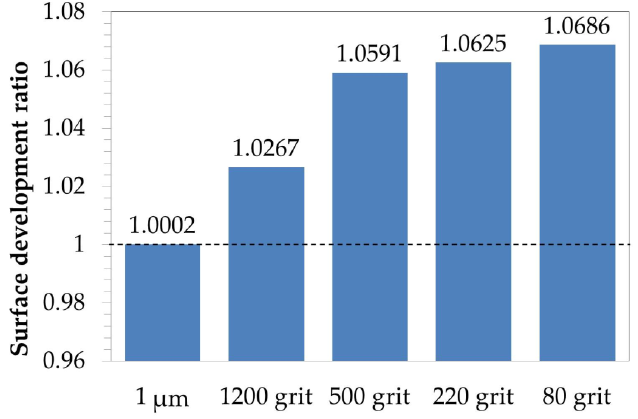
Figure 12. Plot showing surface development ratio referred to an ideally flat surface calculated based on measurement by AFM from Figure 11 for Ni-14Cr-4Al model alloy with different surface preparation method.